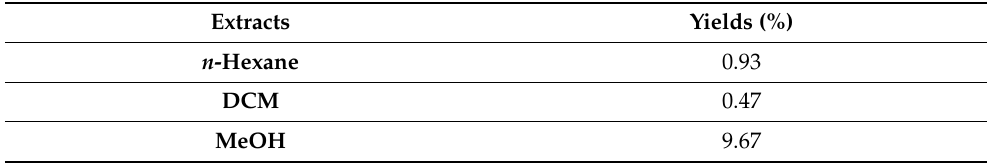
Table 1. Yields (%) of C. aegyptiaca fruit extracts. Extracts Yields (%) n -Hexane 0.93 DCM 0.47 MeOH 9.67